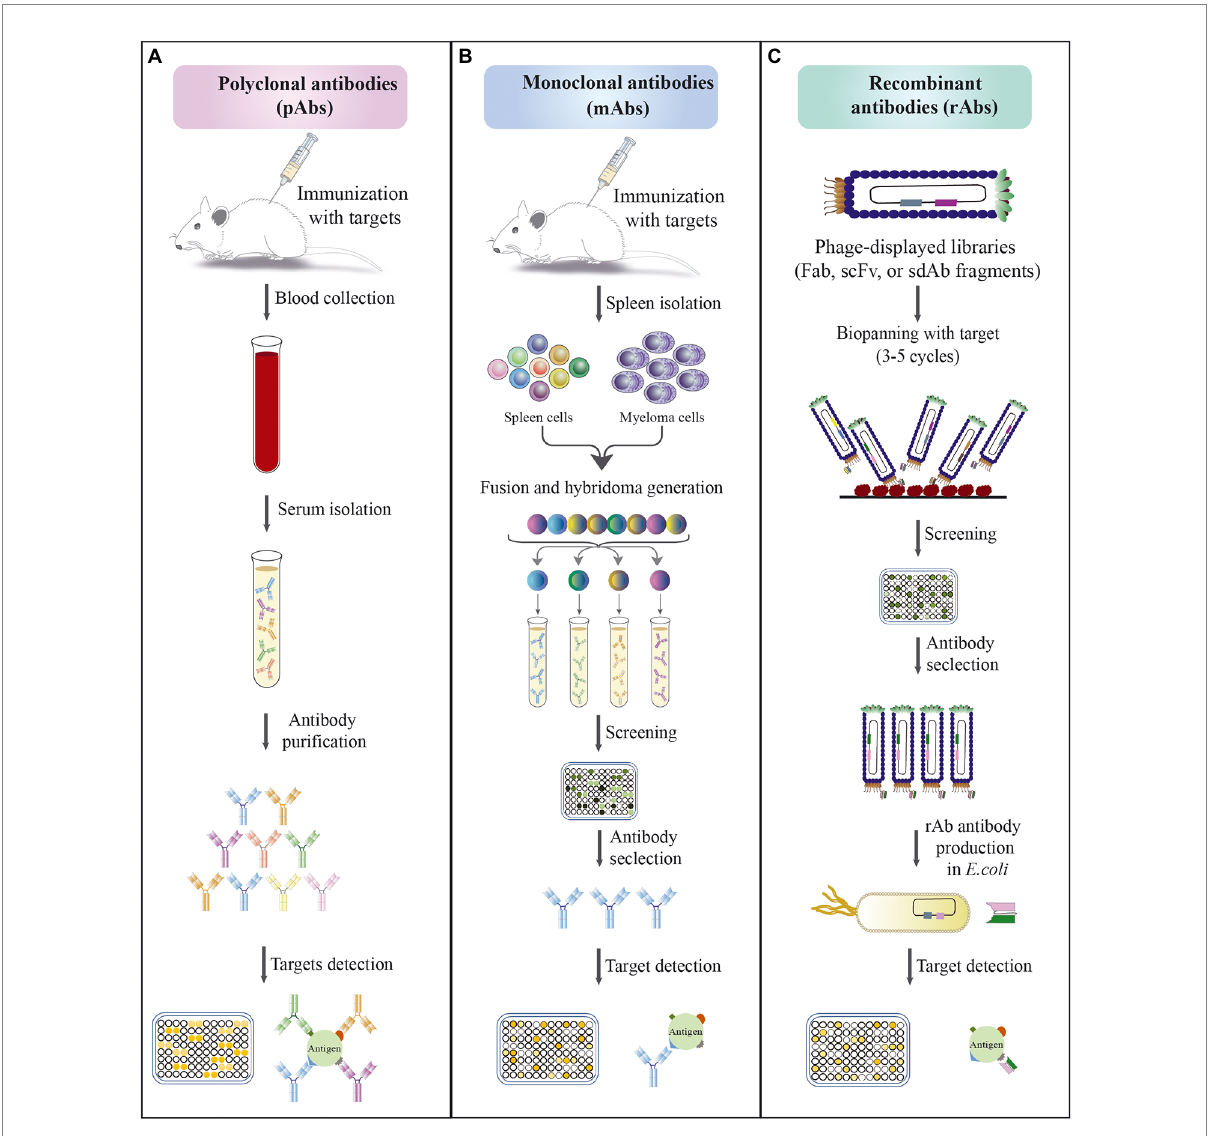
FIGURE 2 Schematic approaches for the development of different types of antibodies. (A) Polyclonal antibodies production; the methods’ steps include: (1) immunization of animals with an antigen to trigger immune response; (2) blood collection from immunized animals; (3) serum isolation; (4) antibody purification; (5) evaluation of the affinity of antibodies against antigen by immunoassay. (B) Monoclonal antibody production by hybridoma technique; the methods’ steps include: (1) immunization of animals with an antigen to trigger immune response; (2) isolation of antibody-producing cells from the mouse spleen; (3) fusion of B cells with myeloma cells to produce hybridoma cells; (4) screening and selection of high affinity antibody produced by hybridoma cells; (5) evaluation of the specificity of selected antibodies against antigen by immunoassay. (C) Recombinant antibody production by phage display technology; the methods’ steps include: (1) amplification of library; (2) exposure of the library to a surface coated with specific antigen; (3) elution of bound phages and their application for a new selection round; (4) screening of positive phage clones by ELISA after 3–5 rounds of biopanning; (5) selection of specific phages and their expression; (6) evaluation of the specificity of selected antibodies against antigen by